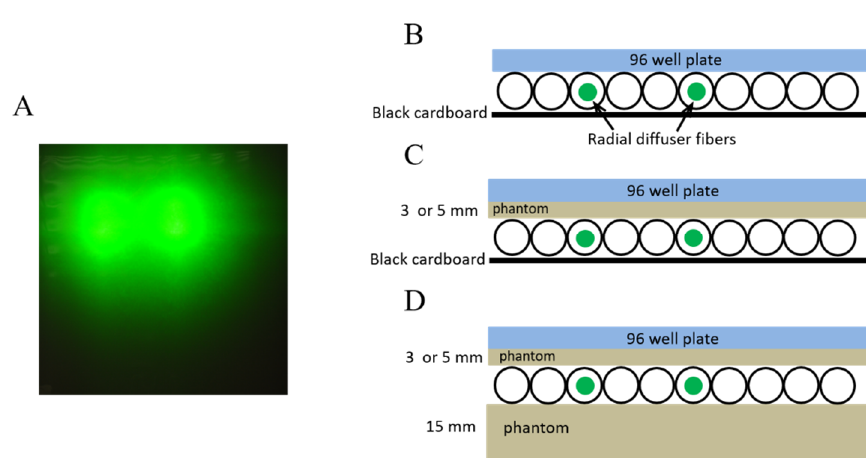
Figure 3. ( A ) A photo of a 3-mm phantom over the optical surface applicator (OSA) with two 2-cm radial diffusers used for the in vitro light administration. Schematic configuration of the OSA, the 96- well plate and phantoms are shown in ( B ) where 96-well plate was placed on top of the OSA silicon beads, ( C ) where 96-well plate was placed on 3- or 5-mm phantoms atop the OSA and ( D ) same as ( C ), where the OSA was placed on a 15-mm phantom (backscatter phantom).